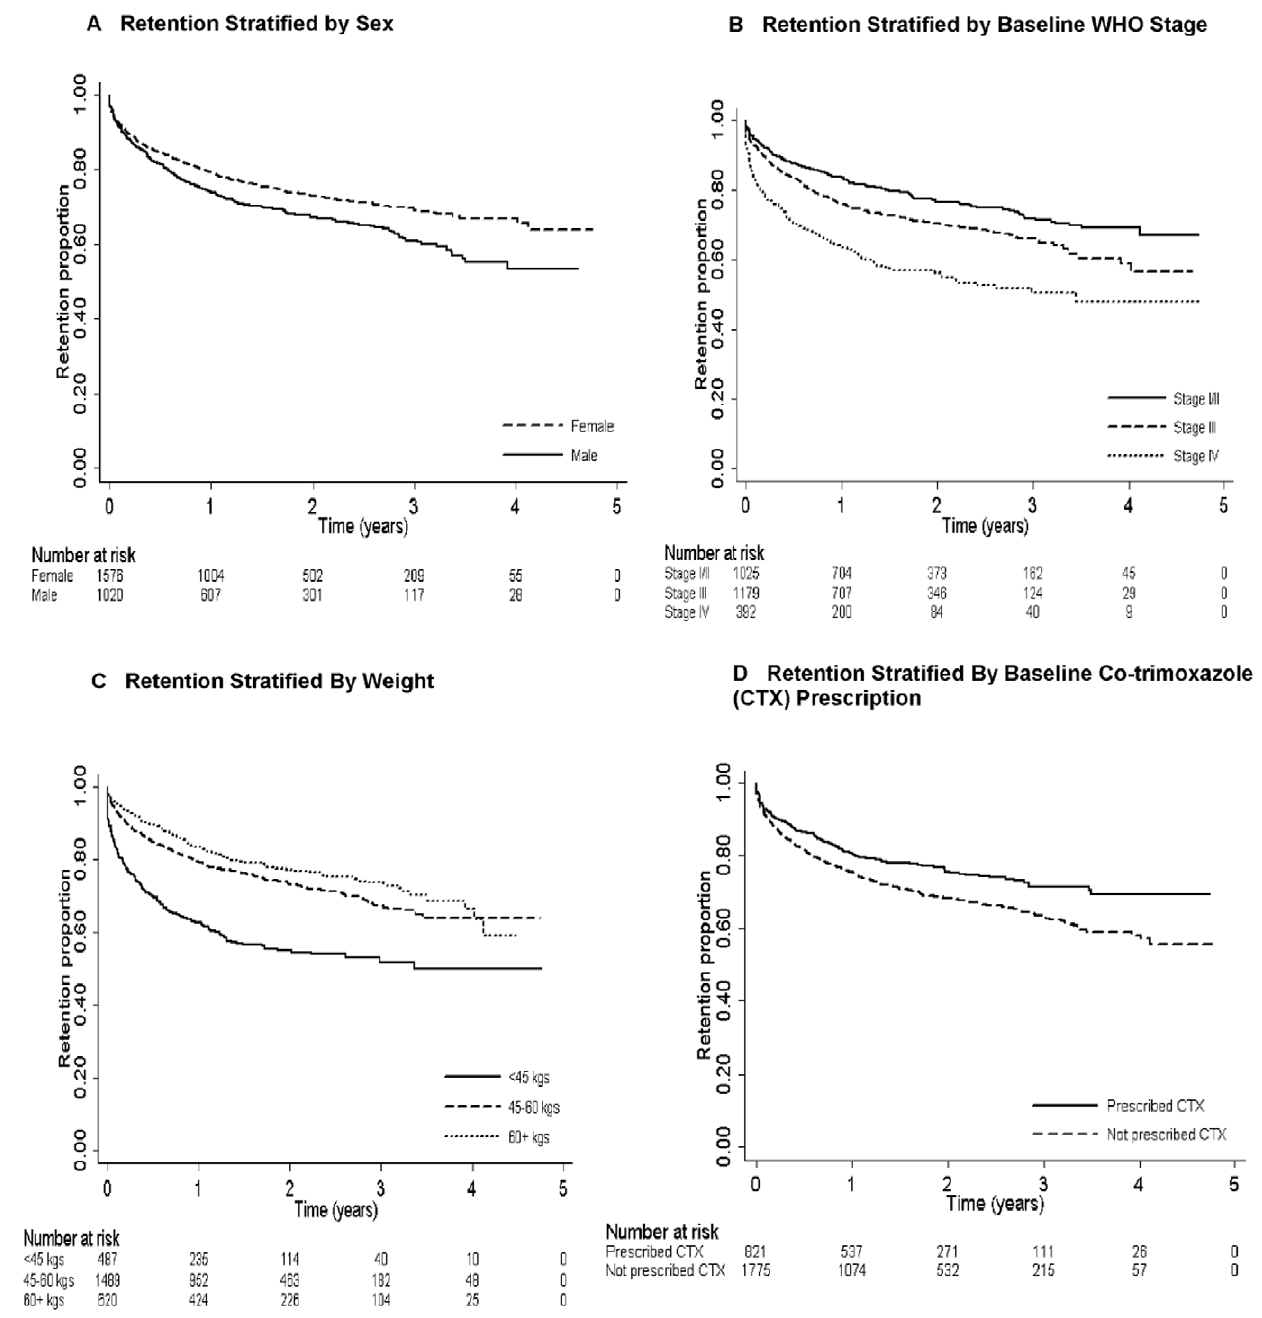
Figure 1. Kaplan-Meier Analysis (imputed dataset 1). doi:10.1371/journal.pone.0018453.g001 of therapy. Proportions of female and male ART patients who were $ 95% adherent to ART were not significantly different (72% vs. 70%, p= 0.12).